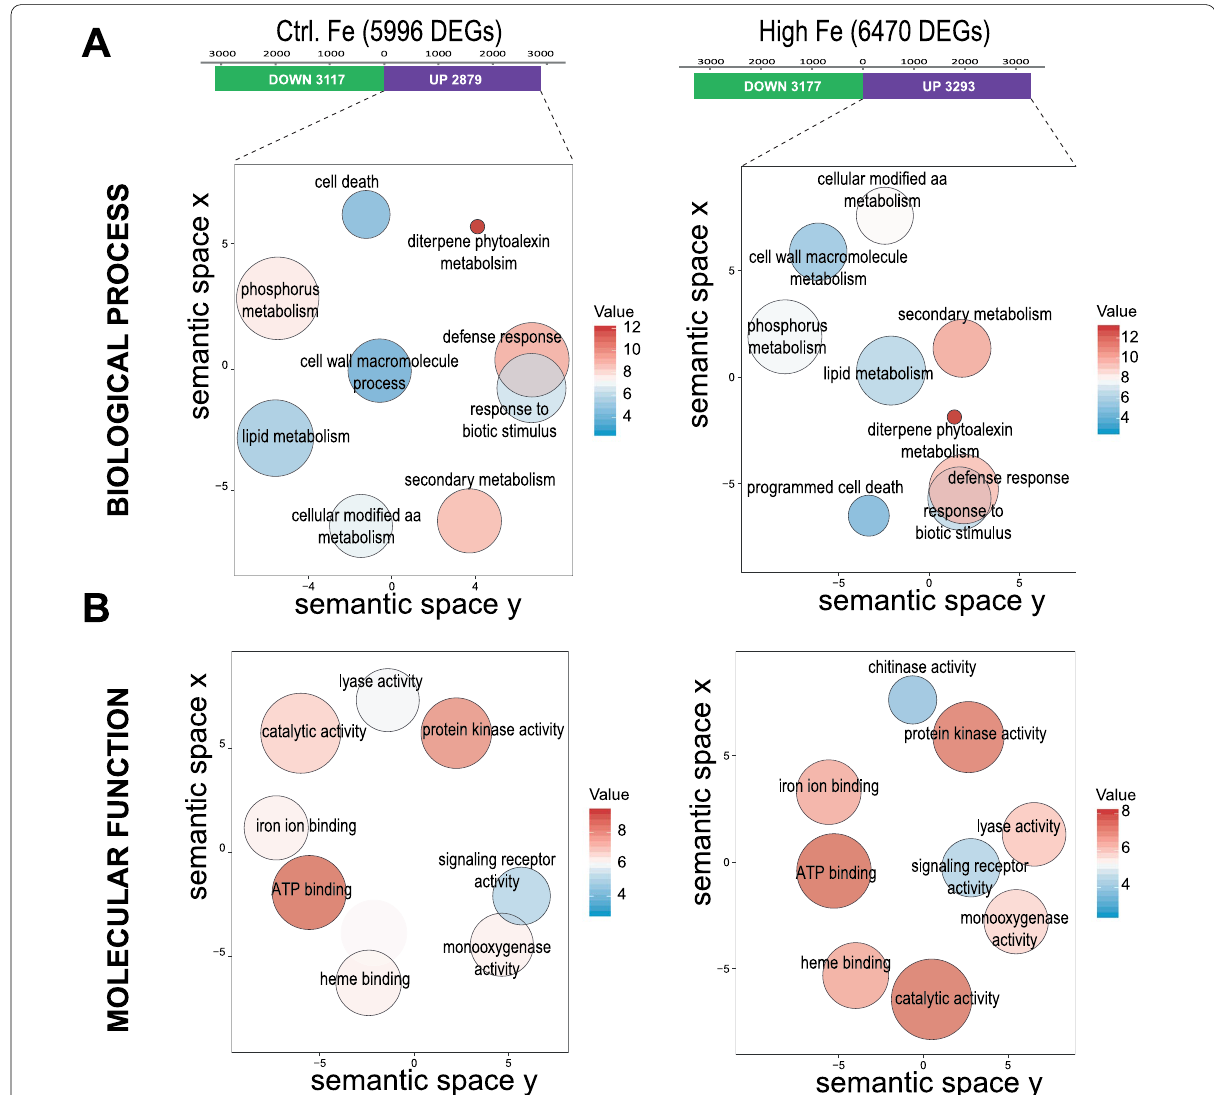
Fig. 3 GO enrichment of genes up‑regulated by M. oryzae infection in Control and High‑Fe plants (48 hpi). The categories of Biological Processes ( A ) and Molecular Function ( B ). GO terms were visualized using REVIGO after reducing redundancy and clustering of similar GO terms in the O. sativa database. GO terms are represented by circles and are clustered according to semantic similarities (more general terms are represented by larger size circles, and adjoining circles are most closely related). Circle size is proportional to the frequency of the GO term, whereas color indicates the enrichment derived from the AgriGO analysis (red higher, blue lower). Full data sets of DEGs and lists of GO terms are presented in Additional file 3: Table S2 and Additional file 4: Table S3,